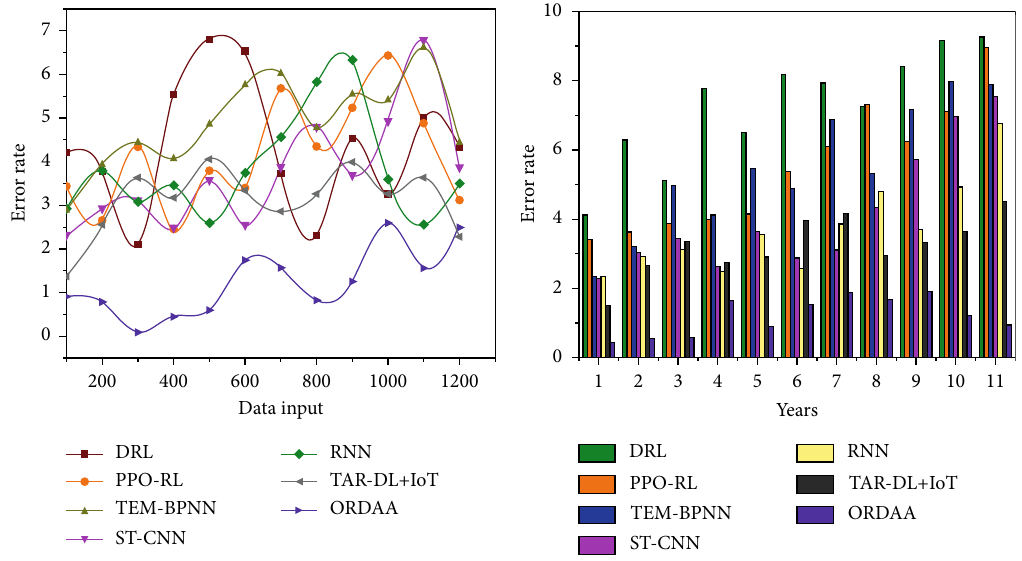
Figure 14: Error rate of ORDAA. Table 2: Comparative analysis results for data